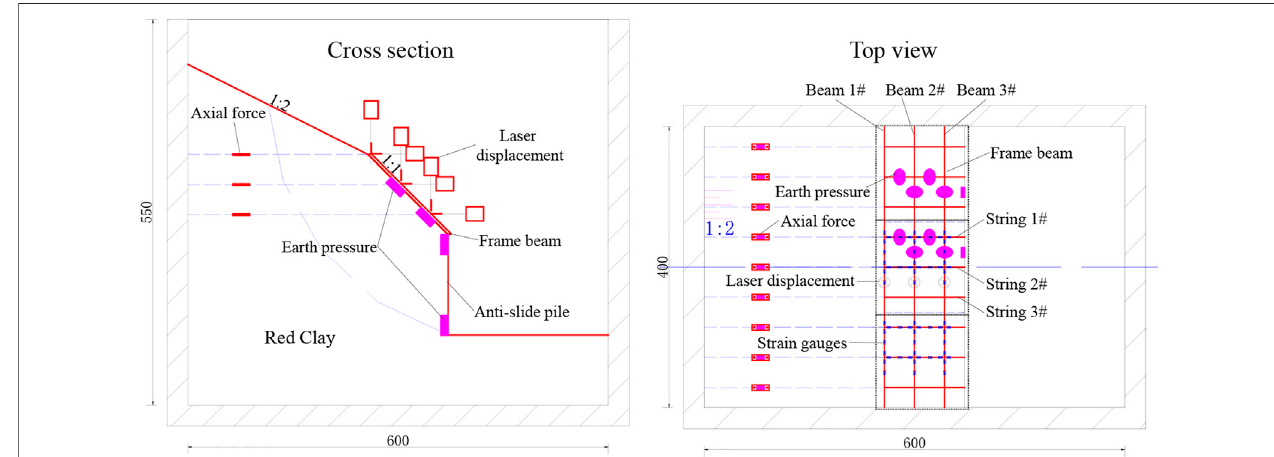
FIGURE 9 | Design drawing of the centrifugal model test.